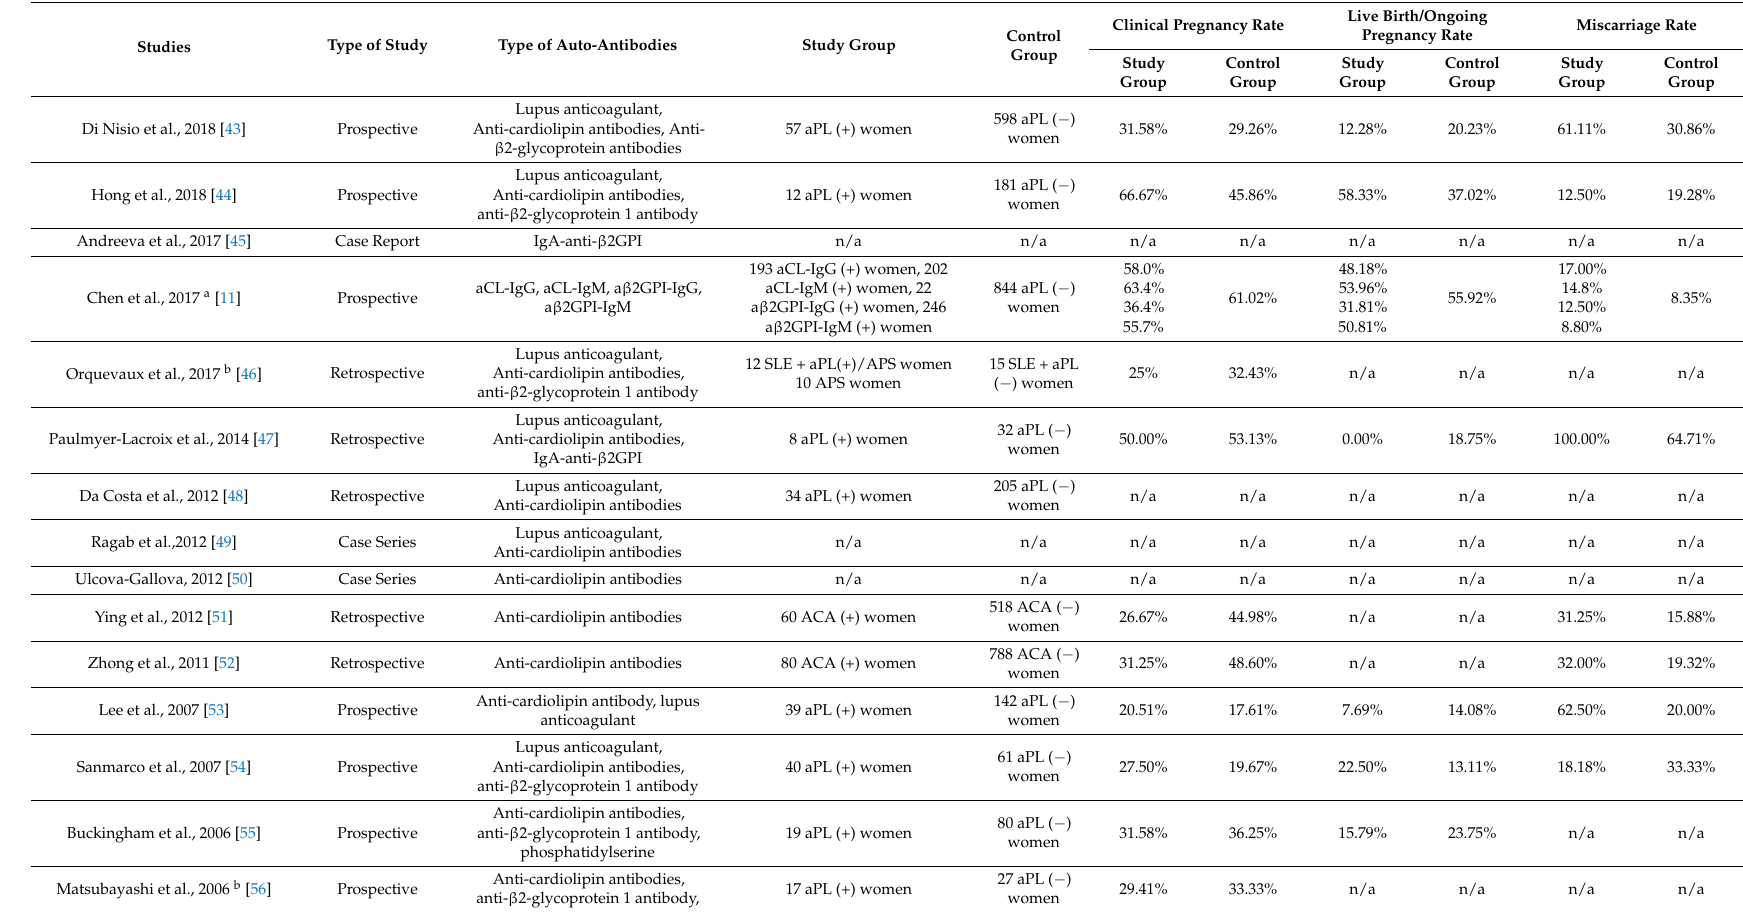
Table 2. Study characteristics regarding anti-phospholipid